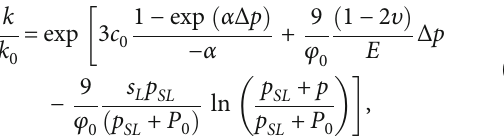
and reduction in elastic modulus. (a) Injection capacity of CO 2